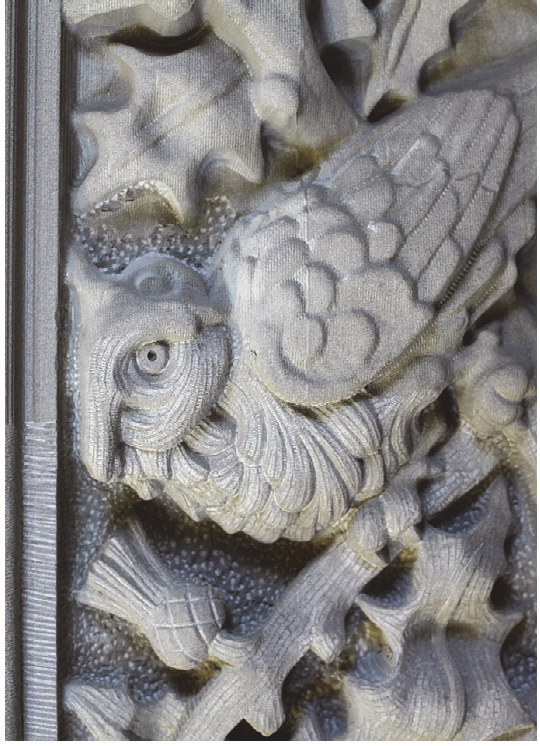
Figure 10. Hand-applied finish on the left and robotic-milled finish on the